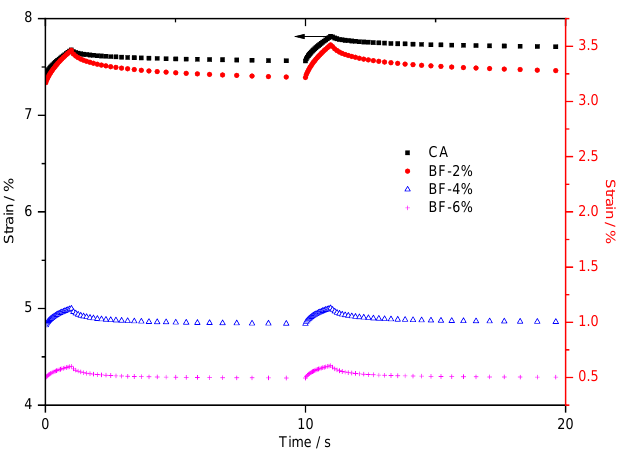
Figure 5. Evolution of strain versus time for composites with brucite fiber in the 50th and 51st cycles. (left Y -axis: CA, as indicated by the black arrow; right Y -axis: BF-2%, BF-4%, and BF-6%).